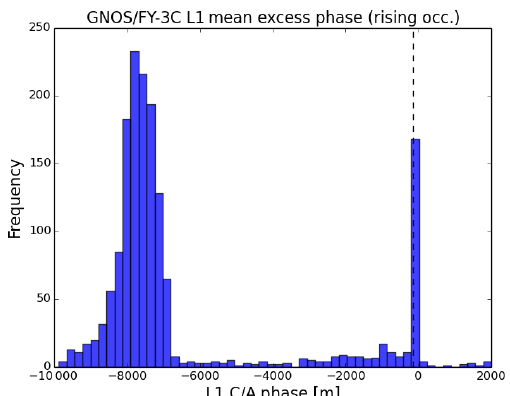
Figure 12. The histograms of L2 mean excess phase for the rising occultation at the height of 60–80km SLTA using 7d of data from 16 to 22 February 2017.